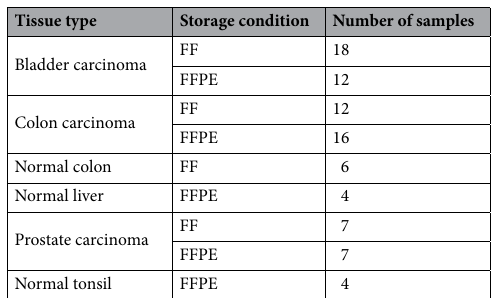
Table 4. FFvsFFPE data. Experimental design according to the tissue of origin and the storage condition.